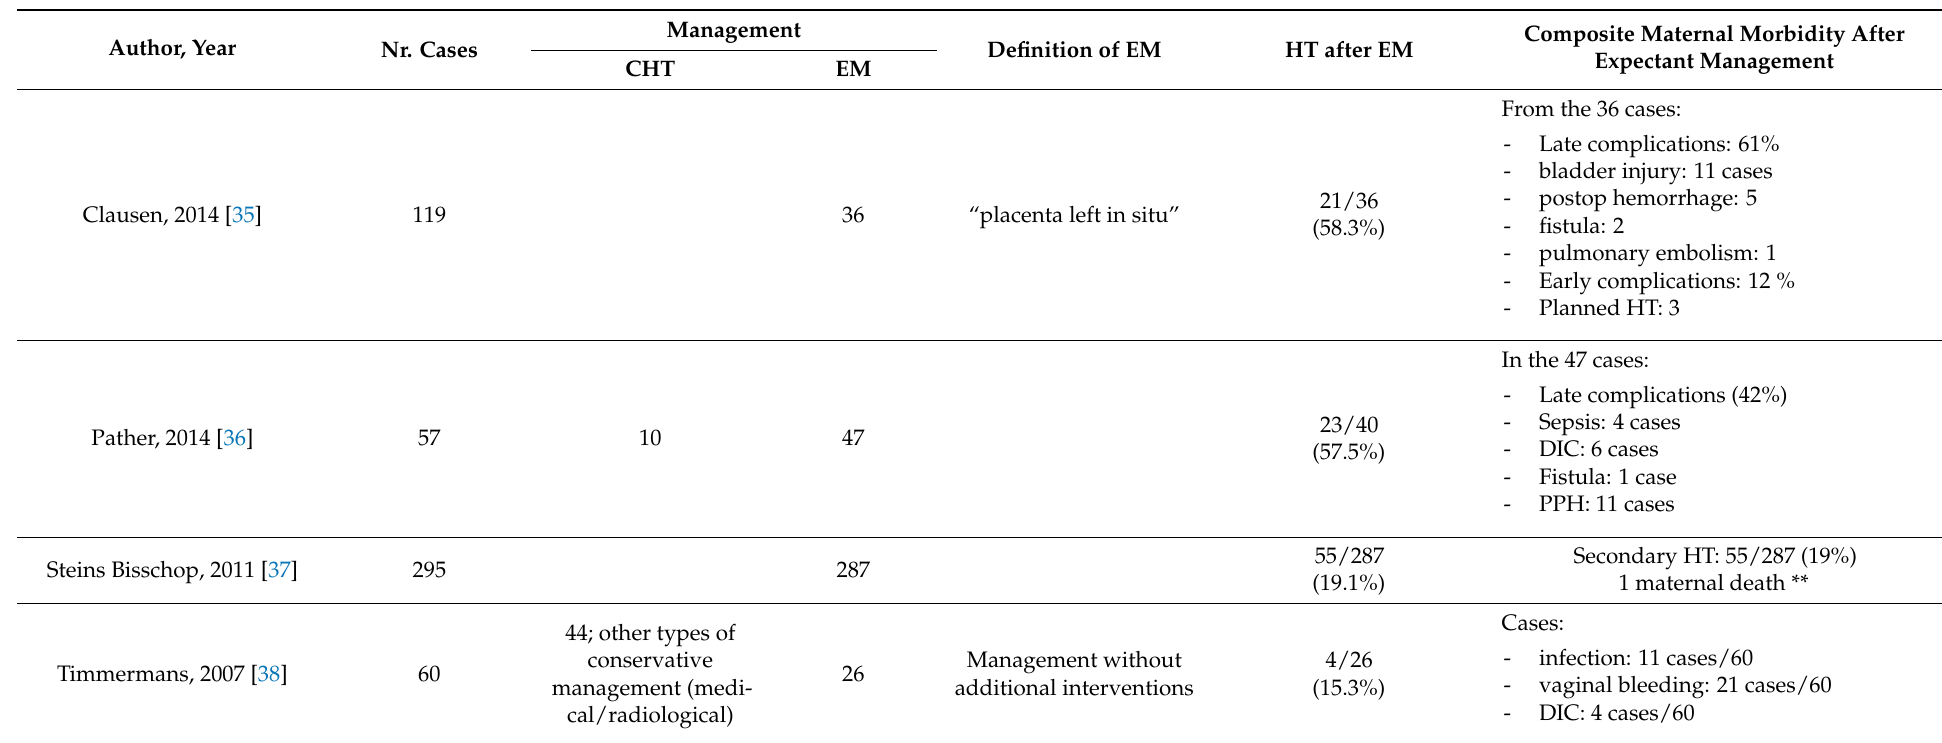
Table 3. Review studies on expectant management in